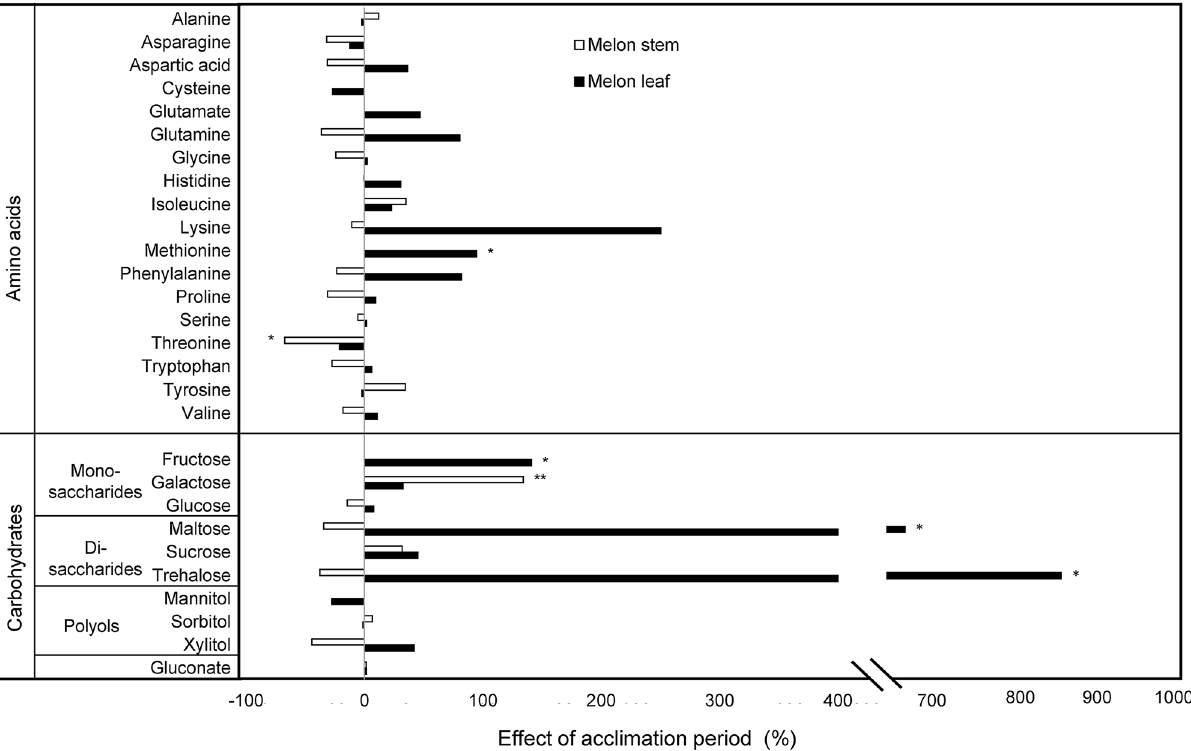
Figure 4. Relative effect of six weeks of acclimation period on the content of amino acids and carbohydrates on leaves and stems of melon plants. Bars represent the percentage change value between 6 weeks (6w) of acclimation period (A.P.) and 2 weeks (2w) of A.P. by the formula: percentage change value (%) = ((6w – 2w)/ 2w) × 100. Results of the effect of A.P. (melon leaf and stem separately) by Two-way ANOVA and LSD tests are denoted by asterisks: *(P ≤ 0.05) and **(P ≤ 0.01) when statistically significant differences were